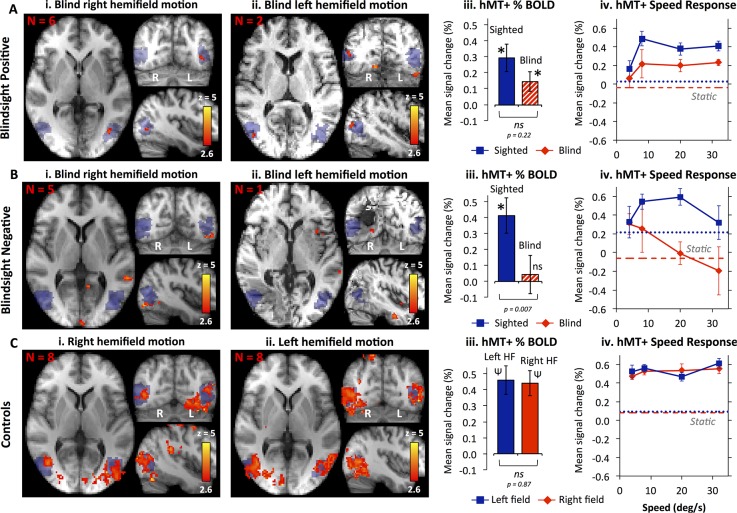
fMRI responses to motion for patients with V1 lesions and controls.Results are shown separately for (A) blindsight-positive patients, (B) blindsight-negative patients, and (C) healthy controls. (i) Significant activity for moving versus static dots in the blind right hemifield of patients with left V1 lesions and (ii) the blind left hemifield of patients with right V1 lesions. Mixed effects analyses, P < 0.001 uncorrected for a priori regions of interest, elsewhere cluster-corrected p < 0.01. Shaded blue areas are binarized Jülich-defined probabilistic maps of hMT+, radiological convention. (iii) Mean contralateral hMT+ signal change averaged across all five stimulus conditions, comparing sighted (blue) and blind (red) hemifields ± SEM. In controls, ‘Left HF’ refers to left hemifield, ‘Right HF’ is right hemifield. * significant activity above baseline p < 0.05, ψ p ≤ 0.001, ns = not significant. P values are from t tests. (iv) Mean signal change in contralateral hMT+ as a function of stimulus speed, shown separately for each hemifield (blue squares are sighted hemifield, red diamonds are blind hemifield). Responses to static stimuli are dotted (left/sighted hemifield) or dashed (right/blind hemifield) lines. Underlying data for iii and iv can be found in S1 Data. fMRI, functional MRI; SEM, standard error of the mean; V1, primary visual cortex.